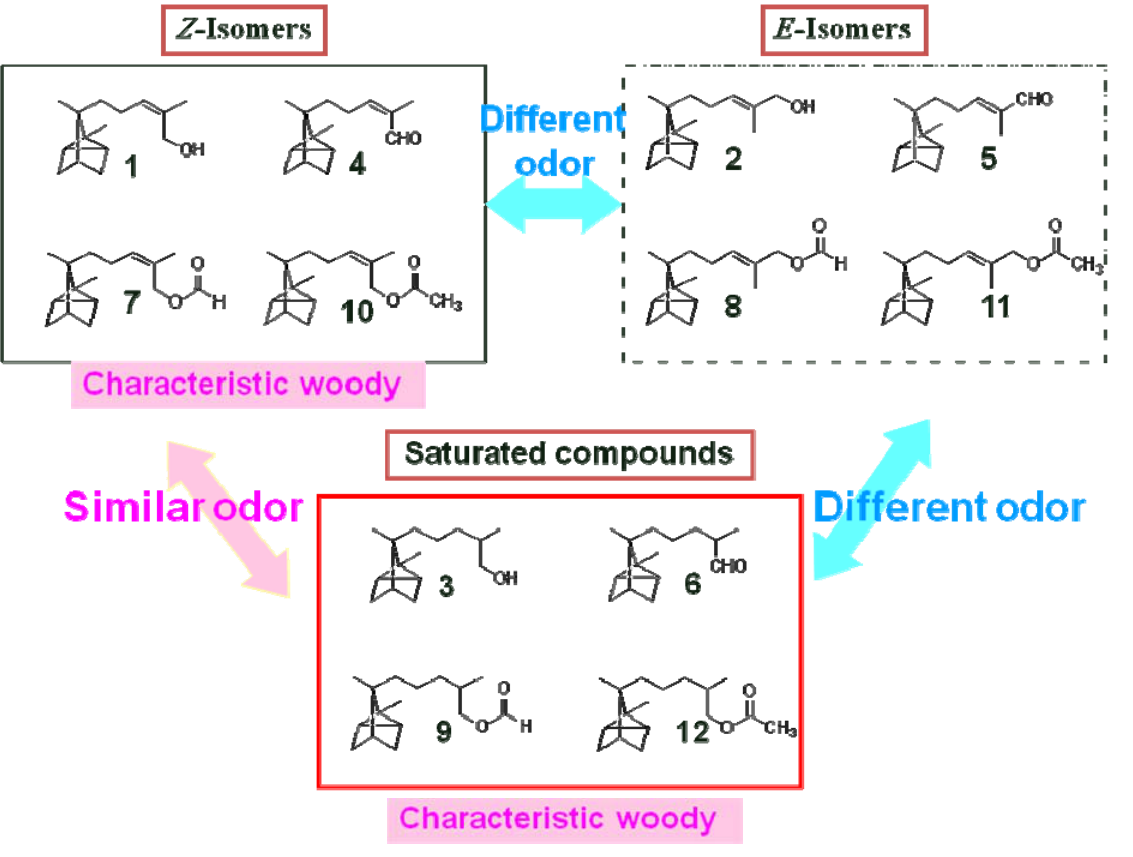
Figure 3. Odor comparison of α -santalol derivatives with four different functional